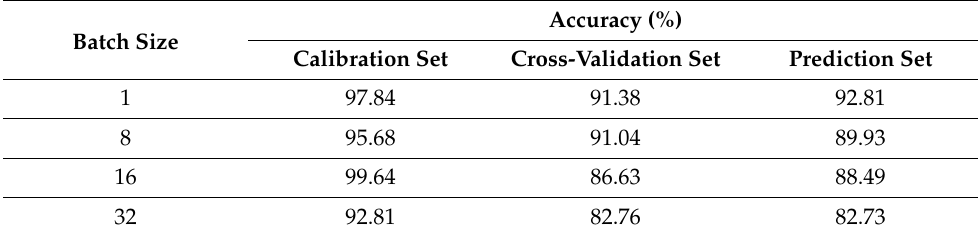
Table 3. The classification accuracies of 1D-CNN with different batch